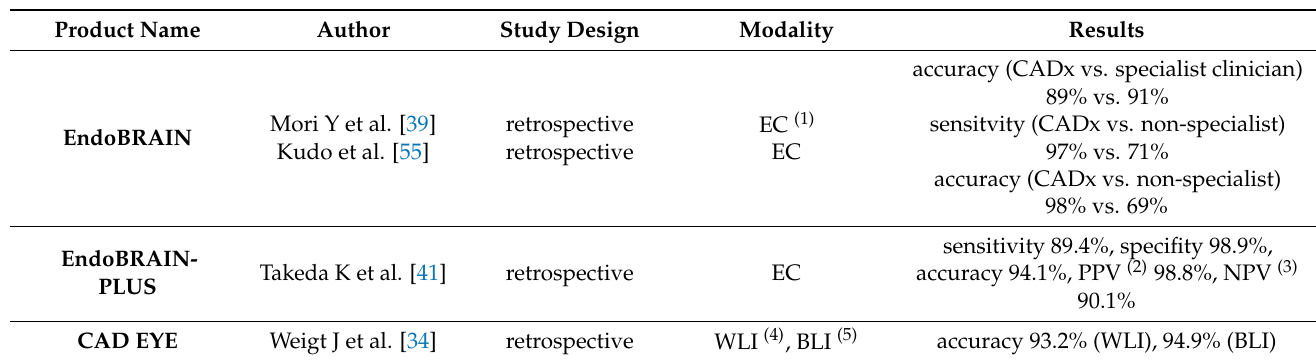
Table 4. Study data of commercial CADx